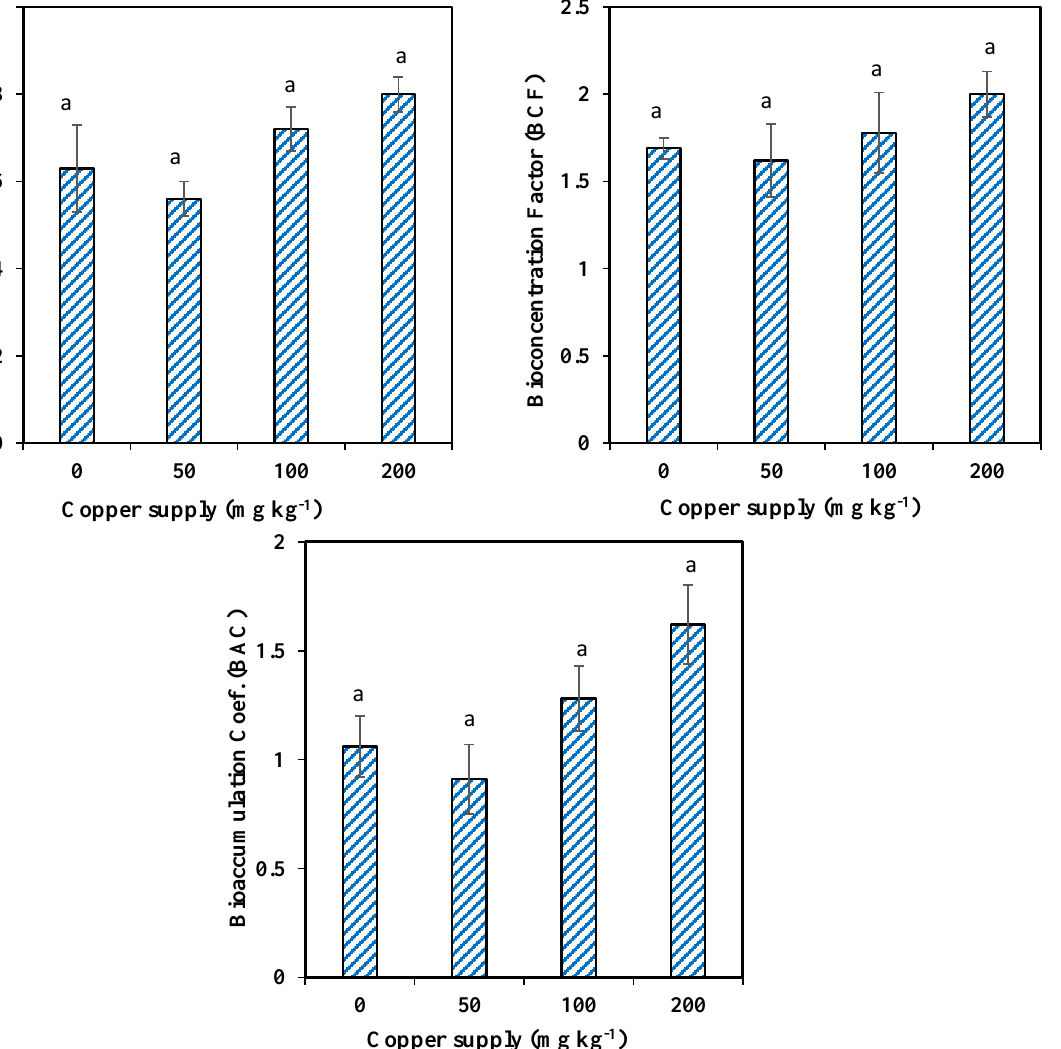
Figure 6. Translocation Factor (TF), Bioconcentration Factor (BCF) and Bioaccumulation Coefficient (BAC) for Cu in the studied treatments. Mean values that do not share a letter are significantly different at p = 0.05 (mean ± S.E.; n = 3).